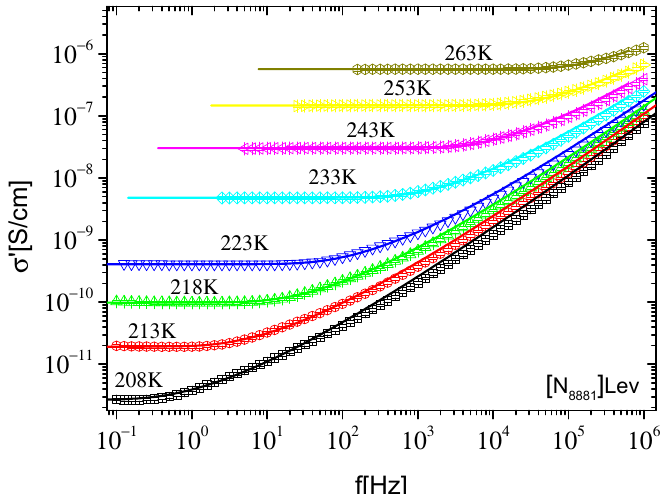
Figure 4. Real part of conductivity σ′ as a function of frequency f at different temperatures, indi- cated on the plot, for [N 8881 ]Lev. The lines are best fits of the expressions of the original RBM per- formed in the frequency region of the dc–ac transition and extrapolated to the whole frequency range .